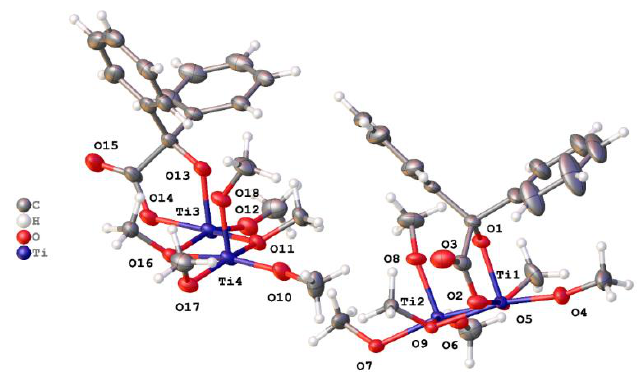
Figure 1. Asymmetric unit of 1 with atoms drawn as 50% probability ellipsoids. (Two symmetry- independent half clusters are present). Selected bond lengths (Å) and bond angles ( o ): Ti(1)-O(4)